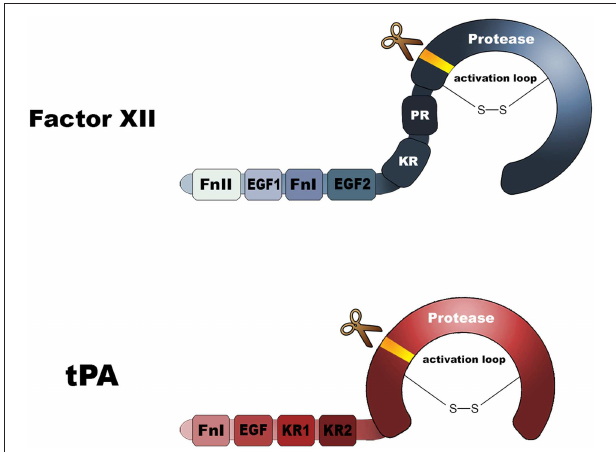
FIGURE 2 | Domain architectures of factor XII and tissue-type plasminogen activator. FnI, Fibronectin type I domain; FnII, Fibronectin type II domain; EGF, epidermal growth factor-like domain; KR, Kringle. Both molecules contain a protease domain that becomes active after molecular scission, resulting in an two-chain disulfide-linked